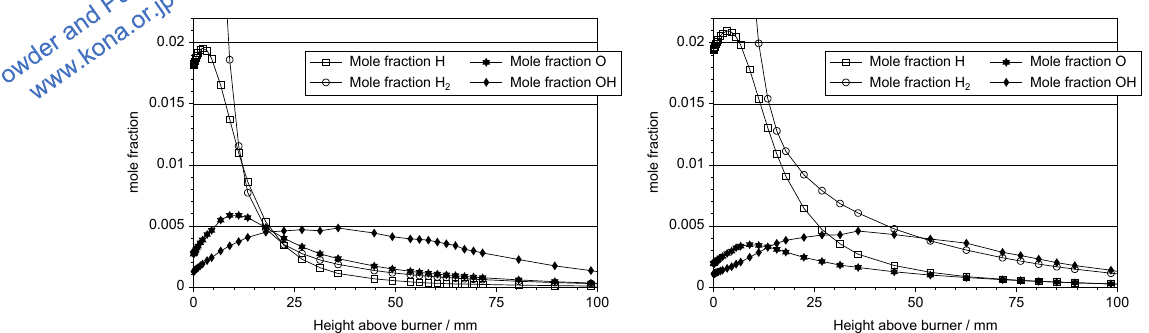
Fig.3 Mole fraction of O ● , OH ● , H ● and H 2 in a H 2 /O 2 /Ar premixed flame calculated with PREMIX™ for Φ = 0.5 (left) and 0.85 (right).